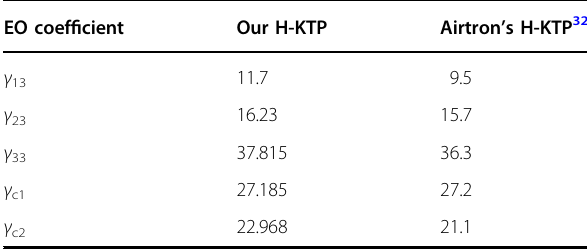
Table 3 Electro-optic coef fi cient of H-KTP Unite: